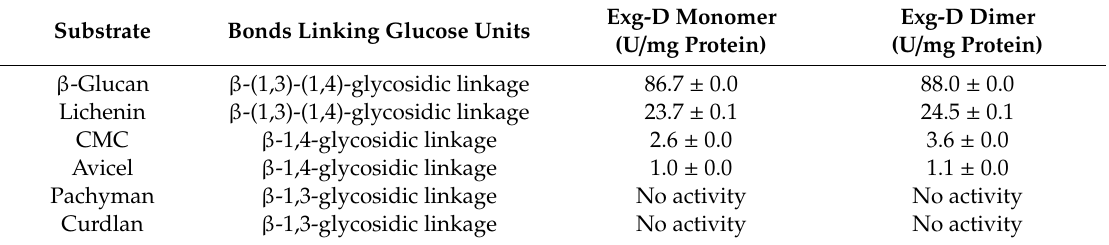
Table 1. Specific activities of Exg-D on substrates linked by di ff erent glycosidic linkages. Substrate Bonds Linking Glucose